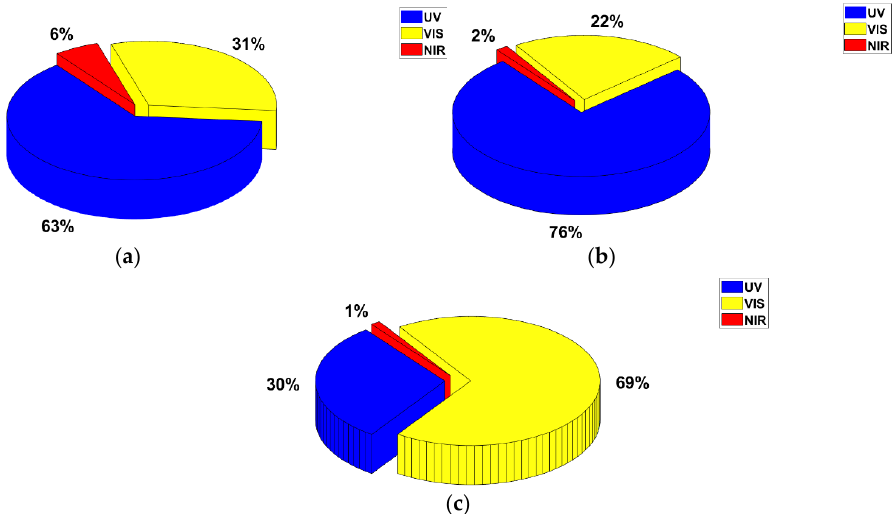
Figure 6. Percentage of optical radiation energy for the analyzed spectral ranges for an electric arc generated in the air at a voltage of 4 kV AC with a frequency 5 kHz ( a ); 130 kHz ( b ); and DC voltage ( c ).